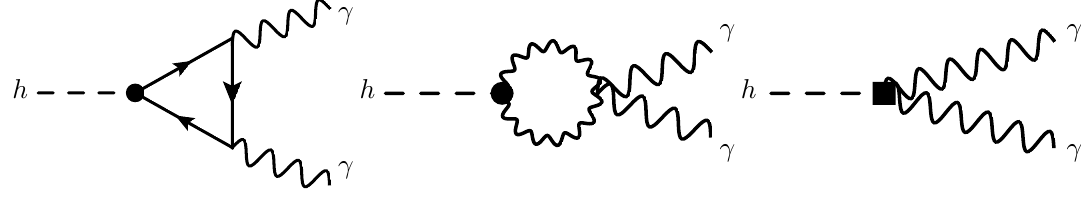
Figure 1 . Schematic contributions to the h ! (cid:13)(cid:13) amplitude. Black dots denote vertices from L LO , black squares from L NLO . All of these contributions introduce deviations from the SM at O ( (cid:24)= 16 (cid:25) 2